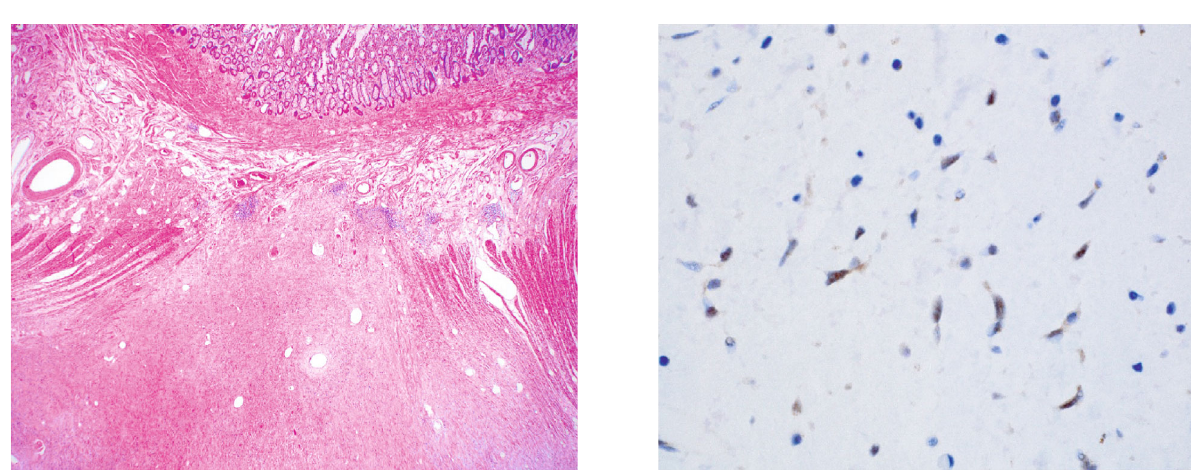
Figure 3: H&E demonstrating SFT with focal invasion of the submucosa at 20 magni fi cation (2x).